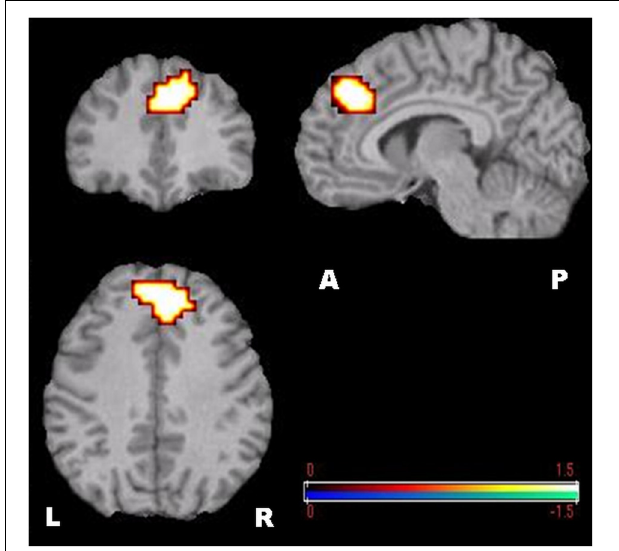
FIGURE 4 | SAM-permutation images of source power changes (event-related synchronization) in the theta (4–8Hz) band. Responses were calculated for the mental calculation (active state) vs. non-arithmetic condition (control state). The color bar represents pseudo- t -values. L, Left; R, Right; A, Anterior; P,